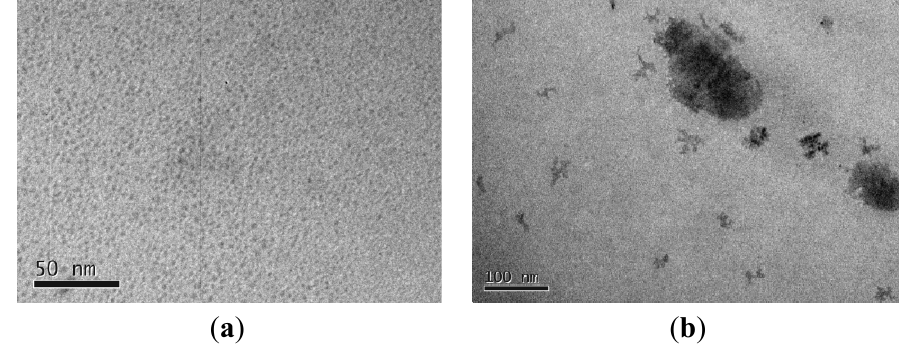
Figure 1. TEM micrograph of MNP ( a ) and MNPC ( b ) . The bars in panels ( a ) and ( b ) represent 50 nm and 100 nm,